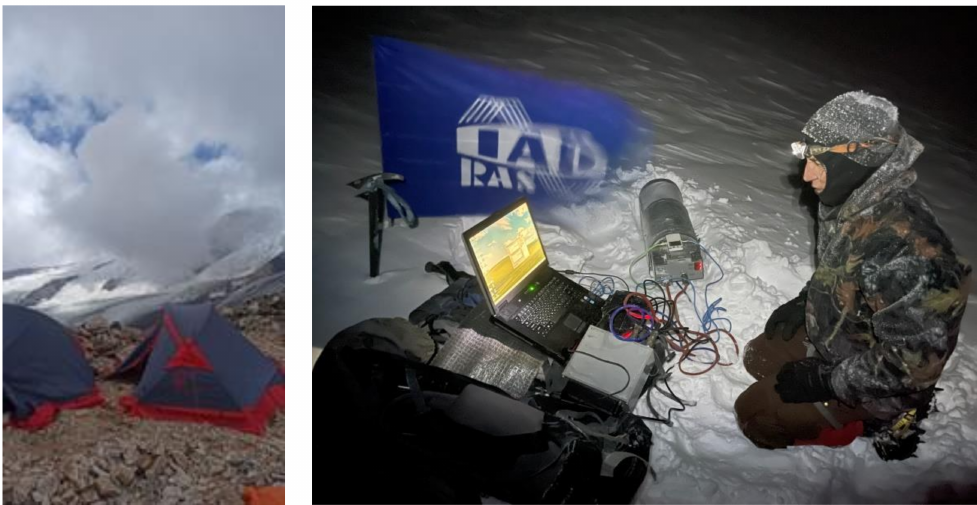
Figure 5. Elbrus IAP RAS expedition August 2021: night measurements at 5630 m made by MIAP-2. There is ~0.25 ± 0.25 Np of absorption of 3 mm